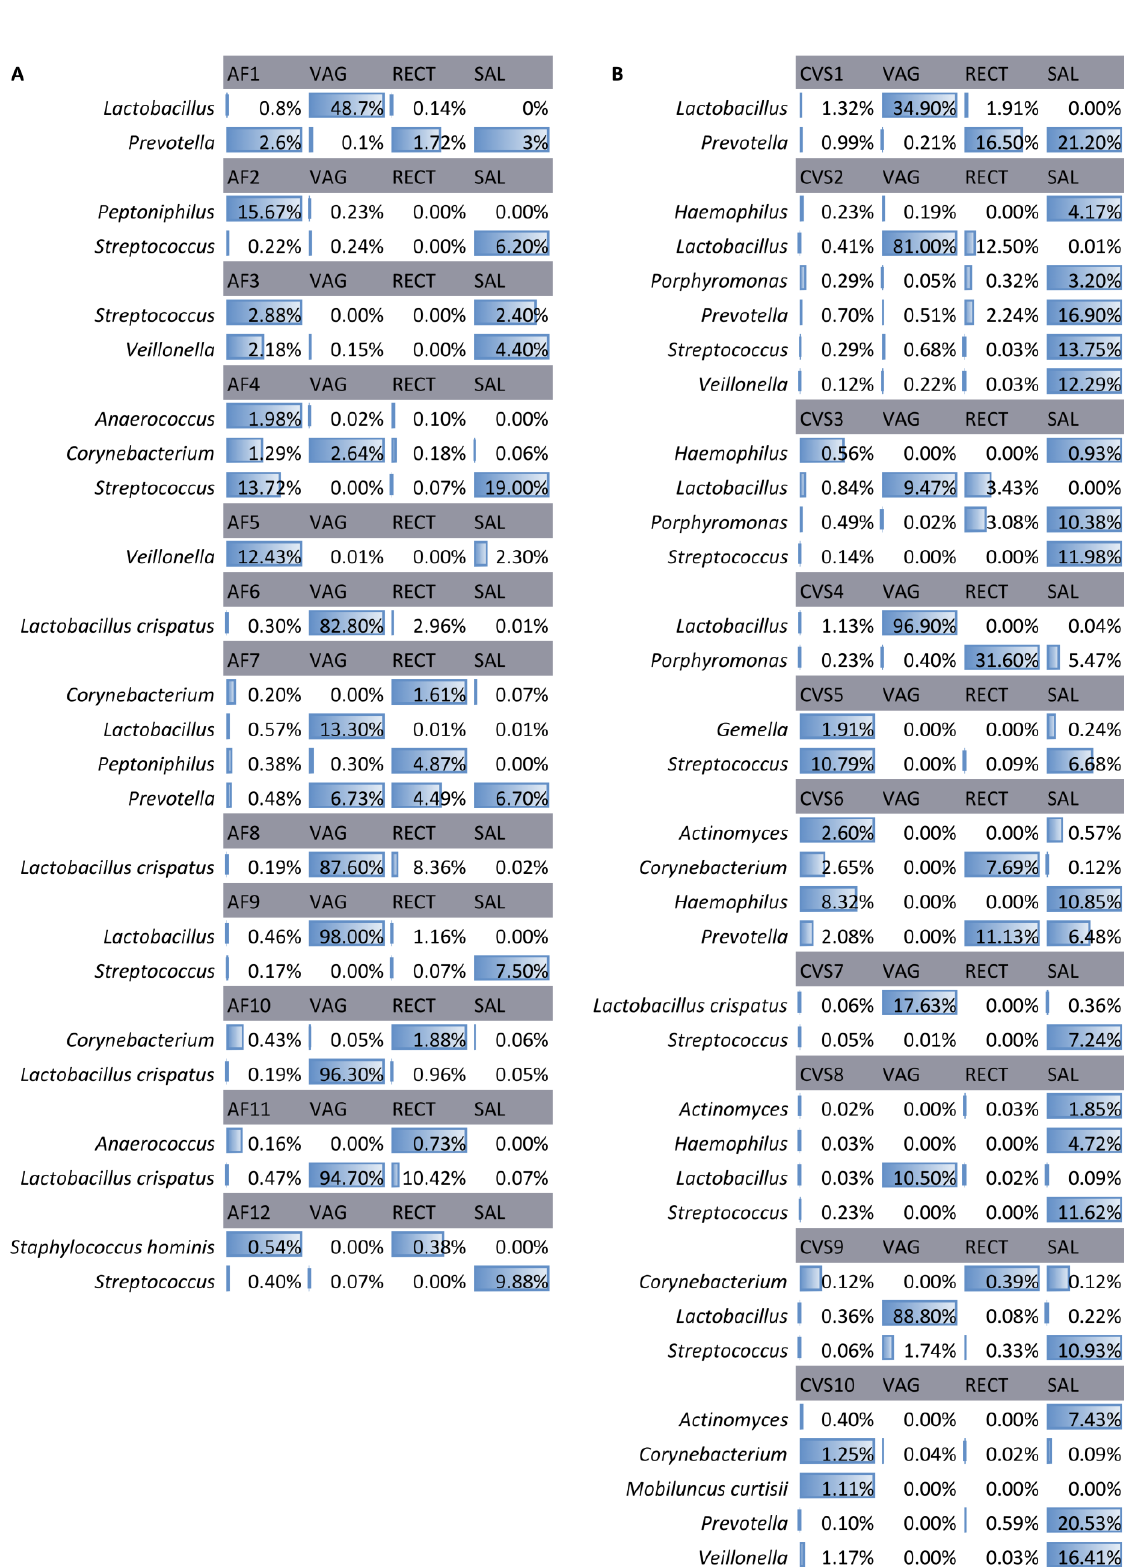
Figure 3. Bacteria in positive AF samples ( A ) and CVS ( B ) and their matched samples. The identified bacteria in the amniotic fluid (AF) samples and chorionic villi samples (CVS) were positive for the presence of bacterial DNA and in the matched vaginal (VAG), rectal (RECT), and saliva (SAL) samples. Data are presented as relative